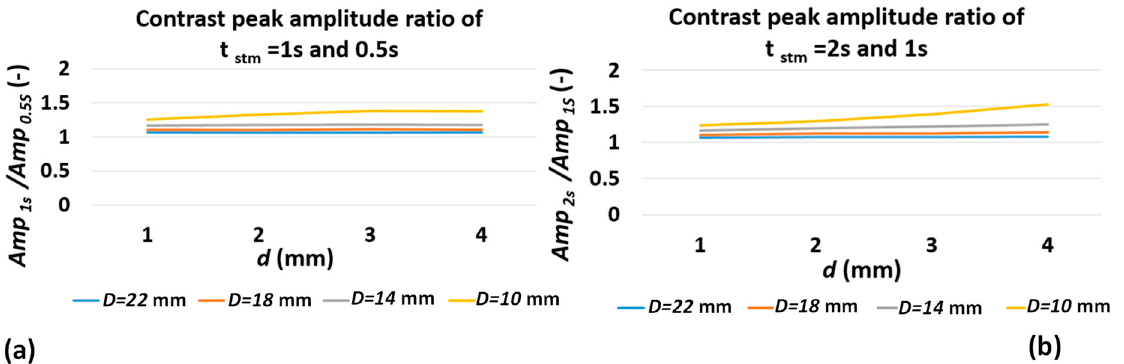
Figure 11. Contrast peak amplitude ratio of ( a ) 0.5 and 1 s and ( b ) 1 and 2 s pulse duration for various defect diameters and depths.